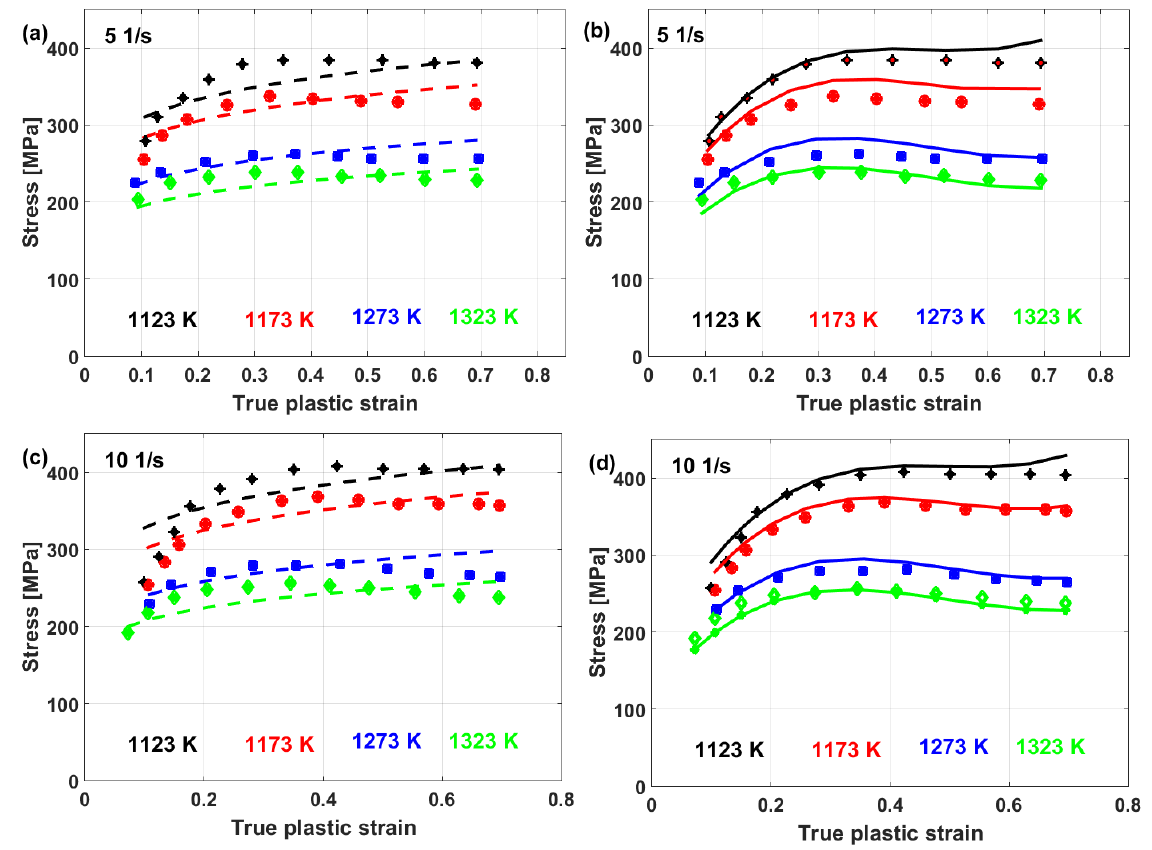
Figure 33. Comparison between experimental stresses (markers) and predicted stresses of alloy 800H obtained using the original JC model (dashed lines) and the modified JC model that was presented by Shokry [84] (solid lines) at ( a , b ) 5 s −1 and ( c , d ) 10 s −1 .